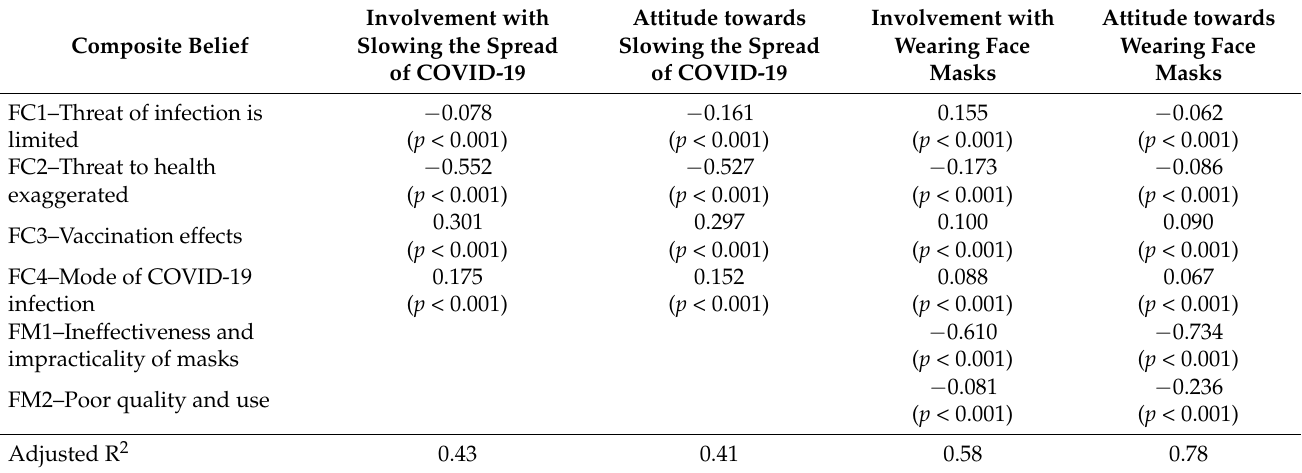
Table 4. Standardised parameter estimates for involvement and attitudes towards preventing the spread of COVID-19 and wearing face